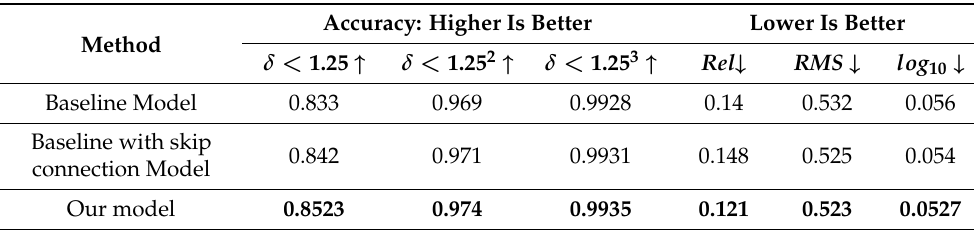
Table 1. Quantitative results of the ablation study on the NYU Depth-v2